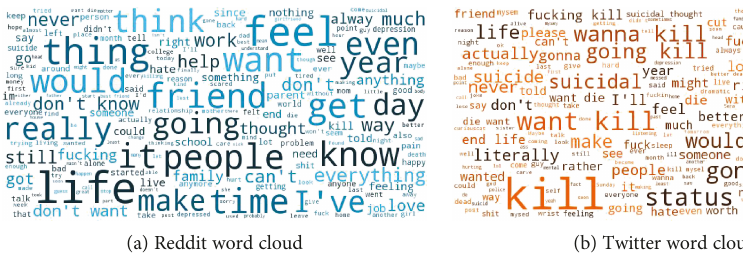
Figure 1: Word cloud visualisation of suicidal texts in Reddit and Twitter. Table 3: Linguistic statistical information extracted by